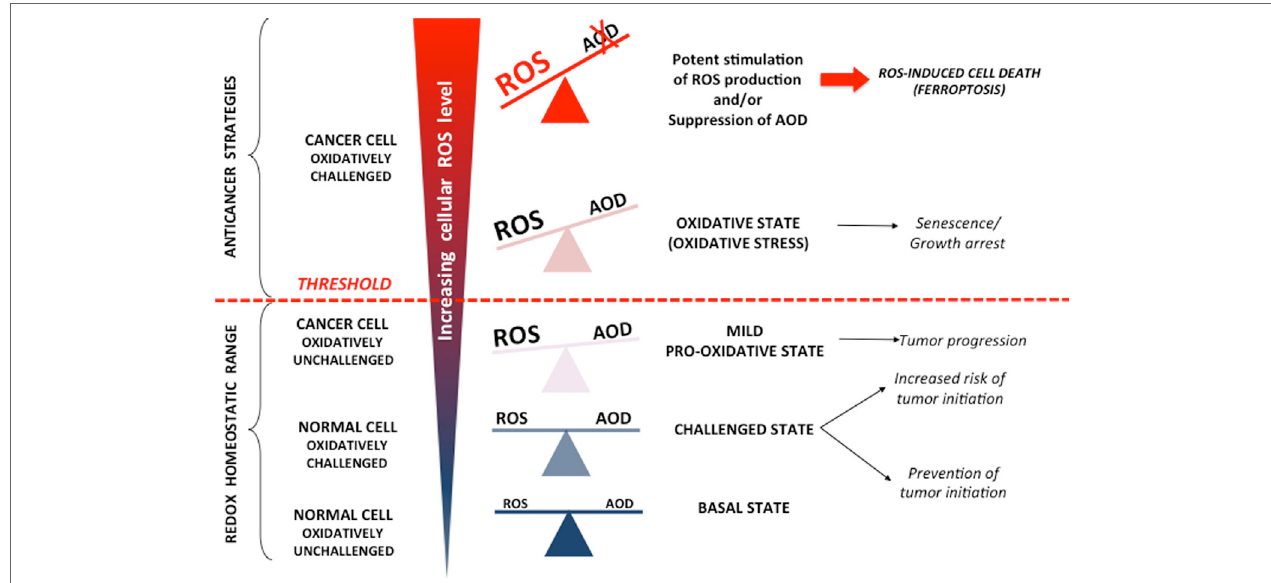
FiGURe 1 | Reactive oxygen species (ROS) can (i) promote cancer, (ii) cause growth arrest, and (iii) be cytotoxic. In normal cells, increased (endogenous or exogenous) oxidative pressure leads to adequate upregulation of cellular antioxidant defense (AOD), which prevent mutagenic events and initiation of cancer formation. However, AOD is not 100% efficient, and thus, these “challenging states” also represent well-known risk factors for cancer development. Once formed, cancer progression seems to be further stimulated by a mild pro-oxidative state due to intensified metabolism, ROS-producing foci, etc. Importantly, this state is still maintained within “redox homeostatic range” thanks to strongly upregulated AOD of cancer cells. However, due to maximized AOD, cancer cells do not support further increase in ROS levels and thus cross the threshold into the state of “oxidative stress.” If ROS level increase further (e.g., due to chemotherapy), the only way for cancer cells to prevent further damage is by decreasing ROS production via cell-cycle arrest to repair damage and prevent cell death (cytostatic effects of ROS). However, if ROS burst induces irreversible damage and/or there is not enough components required for repair systems (e.g., glutathione), cancer cells experience programmed cell death or necrosis (cytotoxic effects of